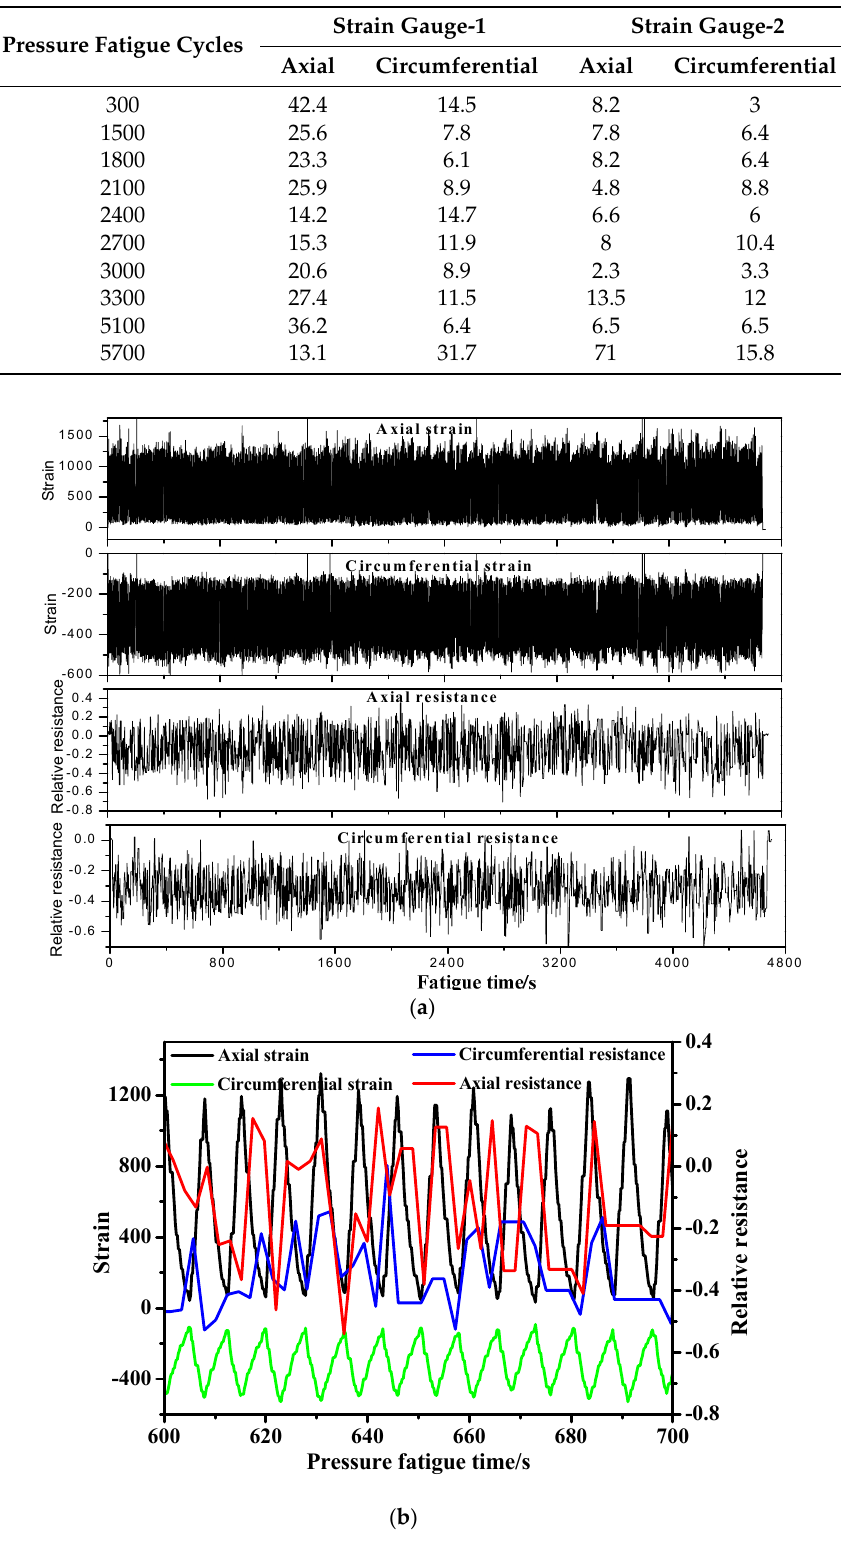
Figure 14. Monitoring results of the MWCNT sensor and the stain gauge when the filament wound pressure vessel is in 5100- to 5700-fatigue cycles. The strain was measured by strain gauge-1 in Figure 4. ( a ) Resistance, the stain as the function of fatigue time. ( b ) The enlarged drawing curves. Table 3. The equivalence relationship between the resistances tested by the embedded MWCNT sensor and the strain gauges.